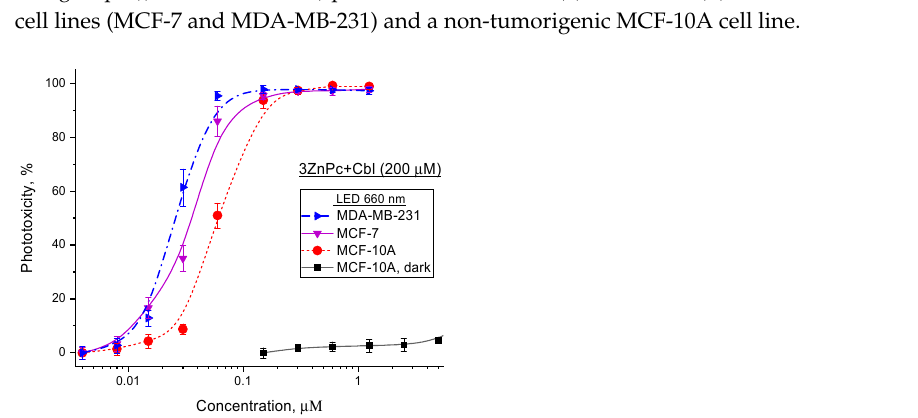
Figure 4. Dark and photo-cytotoxicity of zinc(II) phthalocyanines differing in the position of substitu- tion groups ((3ZnPc and 4ZnPc) presented as followed: ( a ) 3ZnPc and ( b ) 4ZnPc on two breast tumor cell lines (MCF-7 and MDA-MB-231) and a non-tumorigenic MCF-10A cell line.